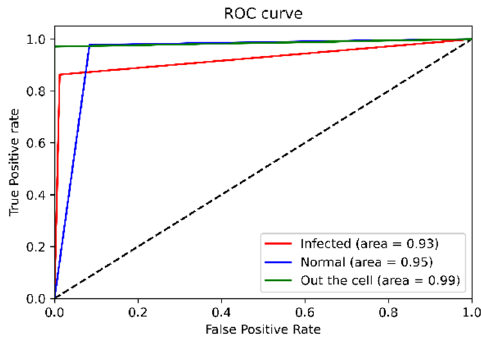
Figure 7. Confusion matrix and each parameter calculation. Figure 7 . Confusion matrix and each parameter calculation. Figure 7 . Confusion matrix and each parameter calculation.